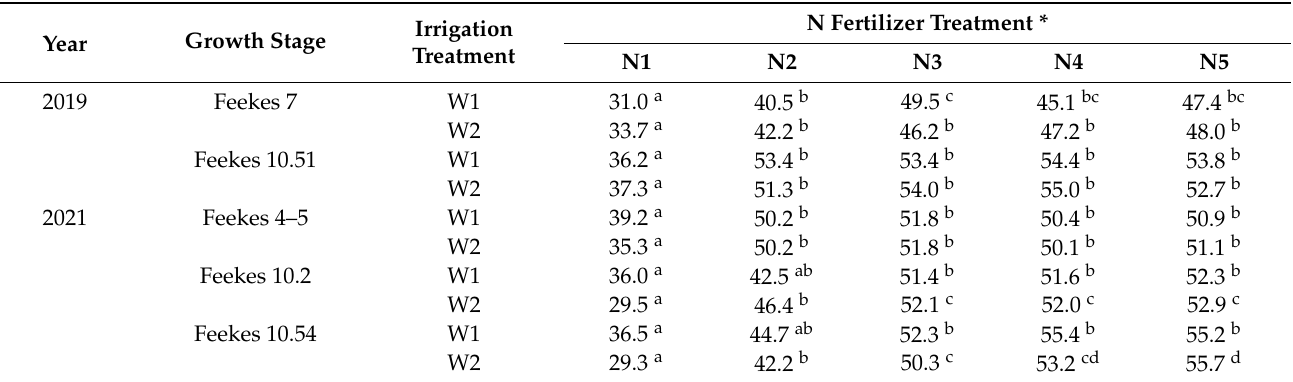
Table 3. Results of significance tests for SPAD under different irrigation and N treatments at different winter wheat growth stages in different years.